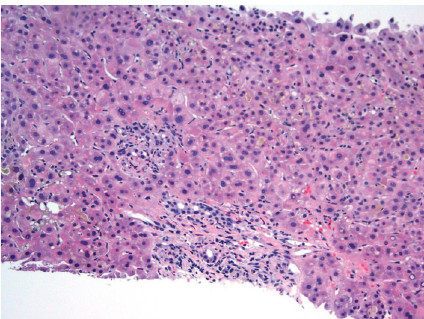
Figure 1: H&E stain (200 × ) showing marked canalicular chole- stasis, portal and periportal fibrosis, bile duct injury, ductular reaction, and portal and lobular neutrophilic infiltrates, most suggestive of biliary obstruction.